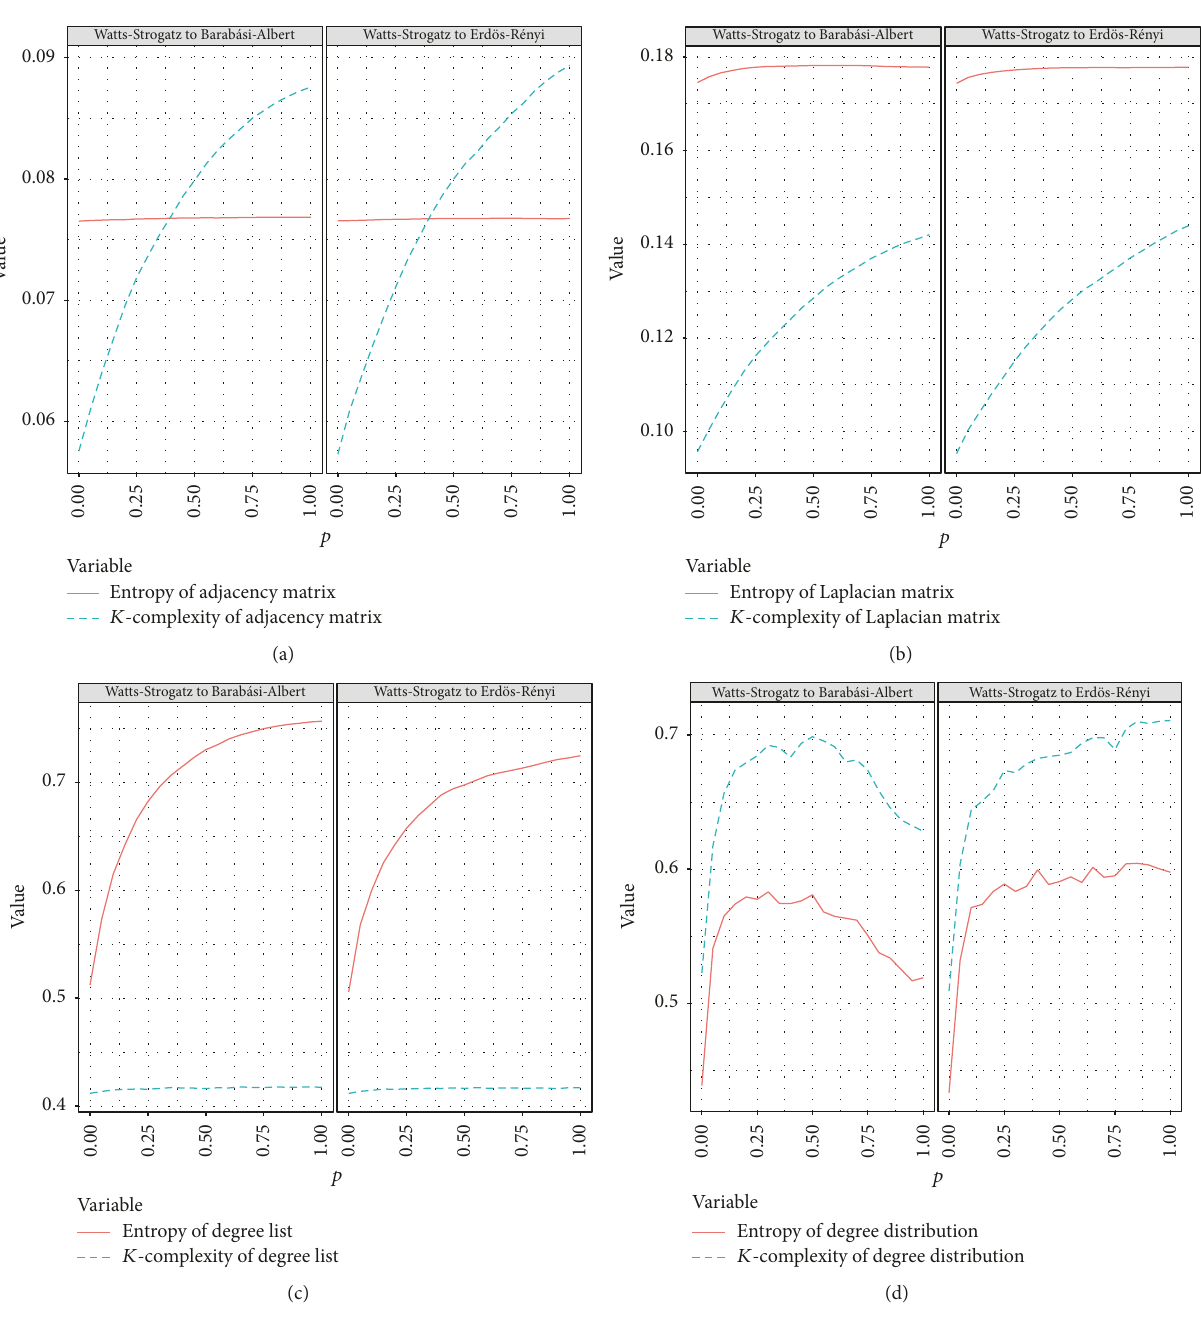
Figure 7: Entropy and 𝐾 -complexity of (a) adjacency matrix, (b) Laplacian matrix, (c) degree list, and (d) degree distribution under gradual transition from Watts-Strogatz model to Erd¨os-R´enyi and Barab´asi-Albert